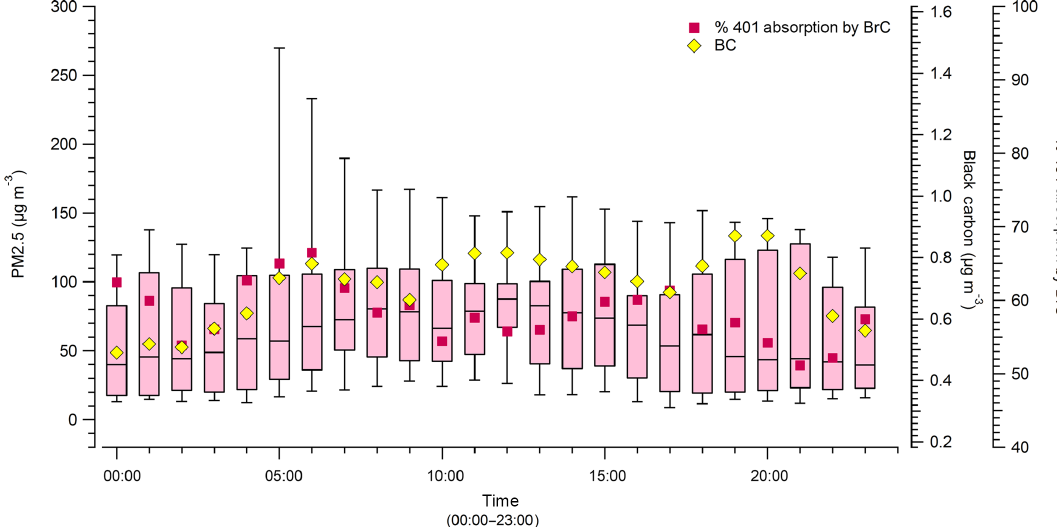
Figure 8. Diurnal plot of average PM 2 . 5 , hourly average %401 absorption by BrC, and hourly average BC. BC and PM shown for the entirety of the monitoring period but %401 absorption by BrC only shown for when the PAX 401 was operational.